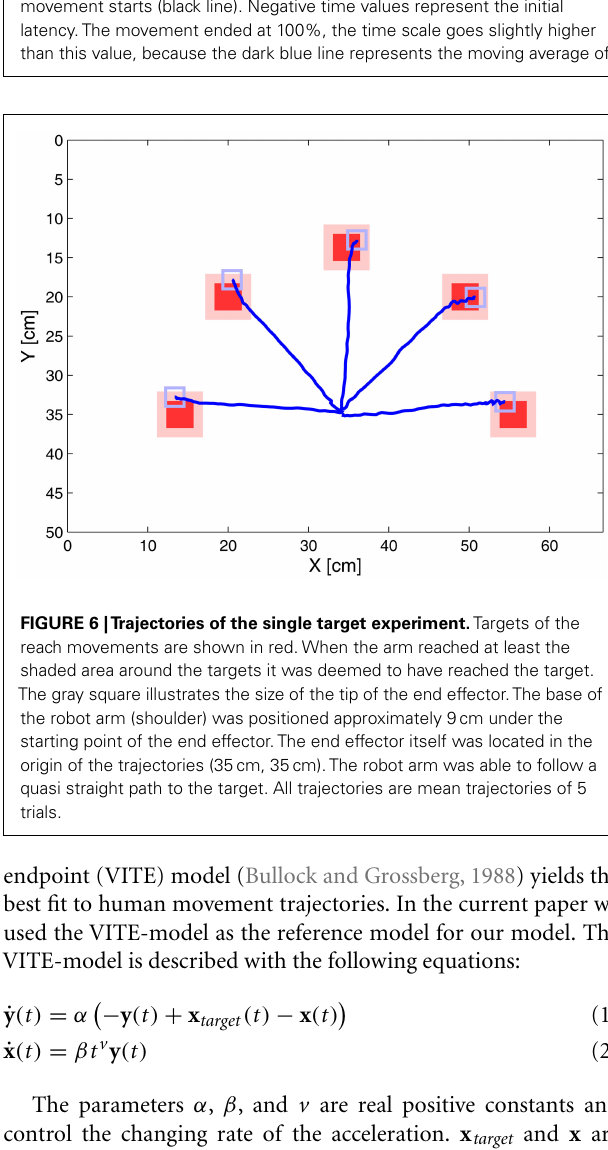
FIGURE 5 |Velocity profiles of the simulated movements to the top center position of Figure 6. The profiles are shown with their standard deviation (light blue area) and the point where the initial latency end and the movement starts (black line). Negative time values represent the initial latency.The movement ended at 100%, the time scale goes slightly higher than this value, because the dark blue line represents the moving average of